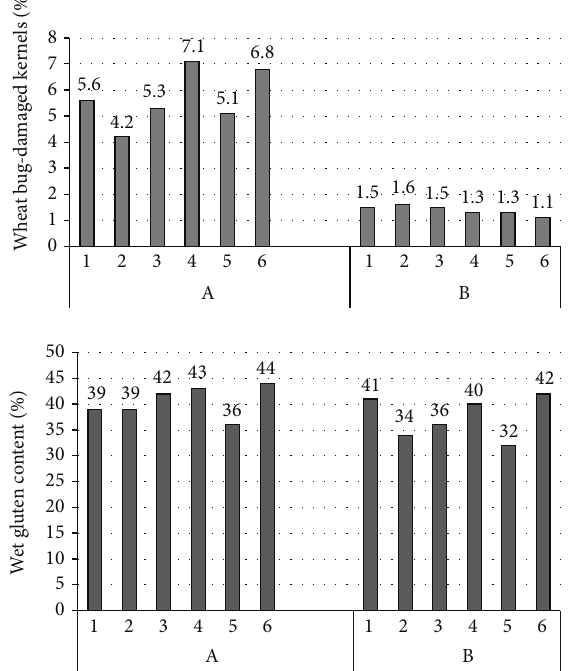
Figure 1: Comparison of observed varieties (1–6) and localities (A and B) with respect to wheat bug infestation and wet gluten